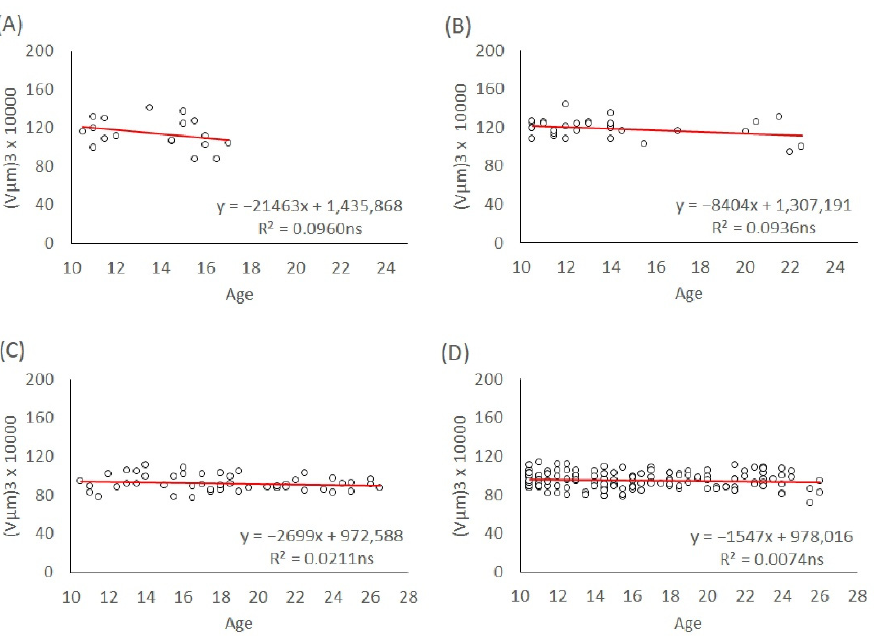
Figure 6. Linear regression of egg size in the maternal age groups above 10 days old. ( A ) L1 male eggs, ( B ) L1 female eggs, ( C ) T male eggs, and ( D ) T female eggs. The significance level of the slope: ns (not significant).